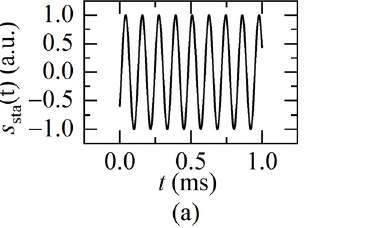
Figure 5. ( a ) The static FSI signal in one sweeping cycle ( L sta = 250 μ m); ( b ) the beat frequency result of the static FSI signal after the FFT.